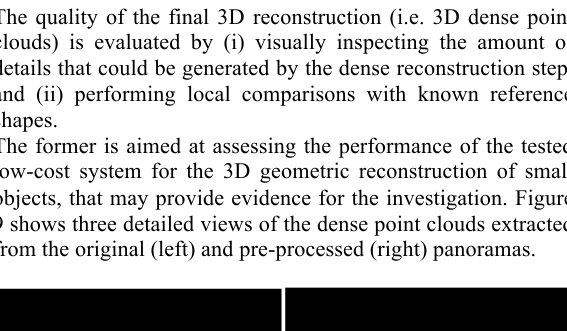
Figure 10. Example of objects which are not reconstructed in 3D neither with original (top) nor with pre-processed (bottom) panoramas.